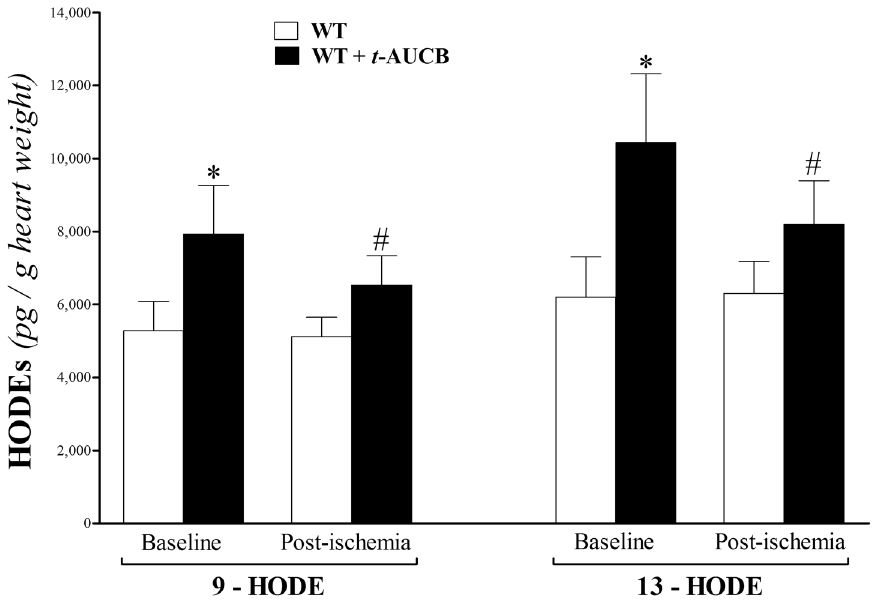
Fig 6. LC – MS/MS analysis of HODEs in WT and t- AUCB-treated WT mouse heart perfusates at baseline (pre-ischemia) and post-ischemia. 9- and 13-HODE increased in t- AUCB-treated WT versus WT mice at baseline and post-ischemia (p < 0.05). Neither HODE changed post-ischemia versus baseline within the same group (p > 0.05). * p < 0.05 versus baseline WT. # p < 0.05 versus post-ischemia WT. n = 8.